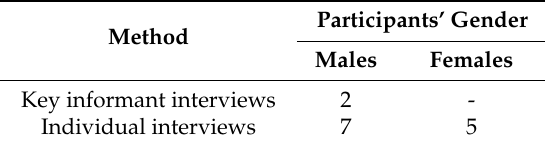
Table 1. Participant distribution and data collection method.